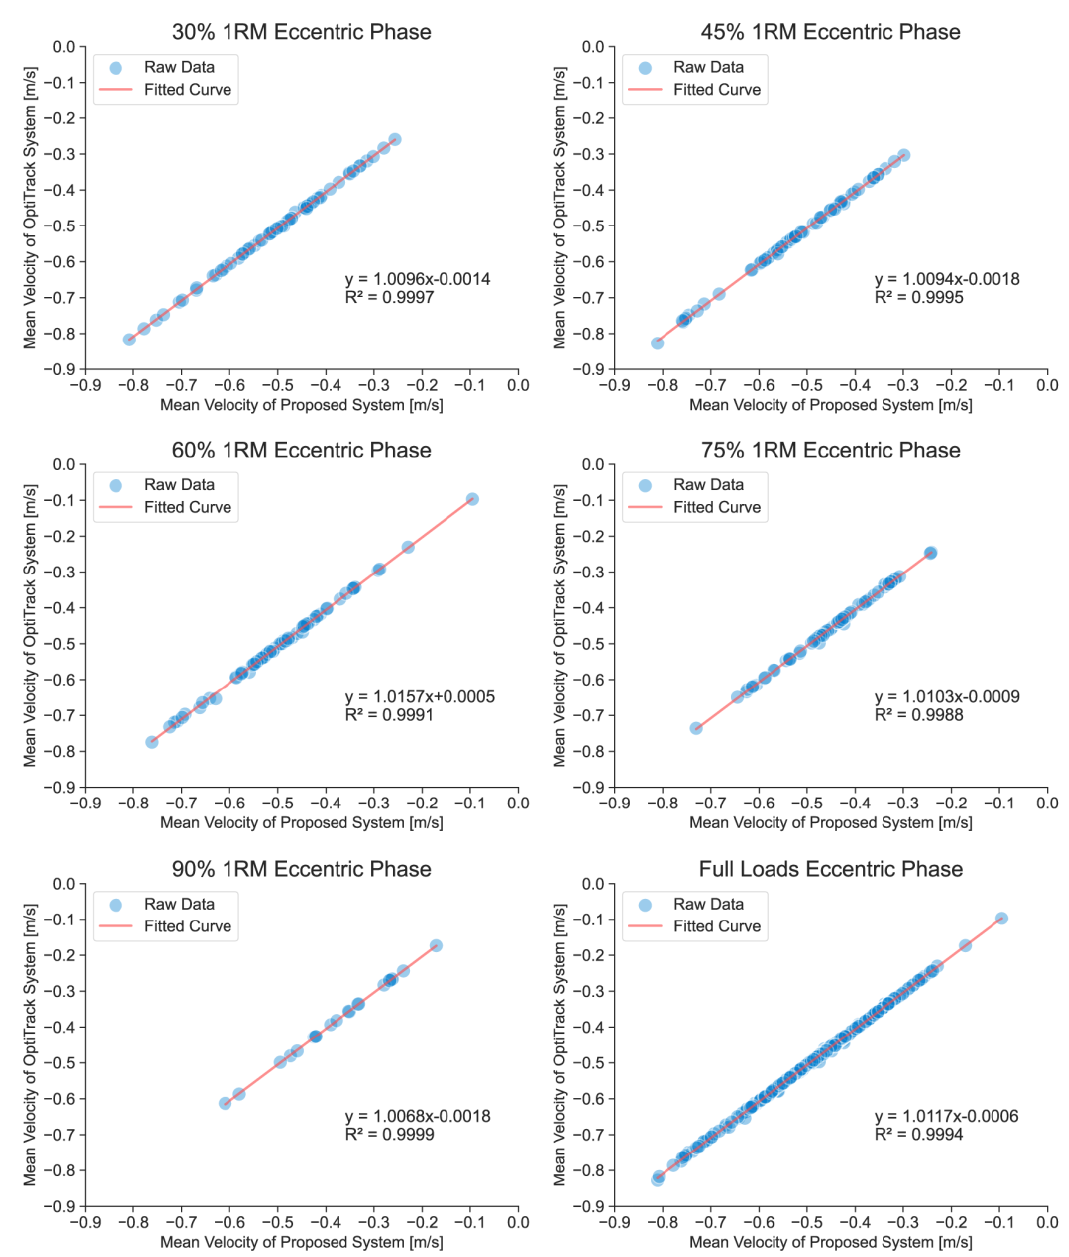
Figure 8. Linear regressions of mean velocities in the eccentric phase under different loads, measured by the FRTMS versus the OptiTrack system. The Full Loads graph is the regression of all relative loads’ average velocities. The positivity or negativity of the velocities represents the direction of movement: negative velocity means downward movement, while positive velocity means upward movement.